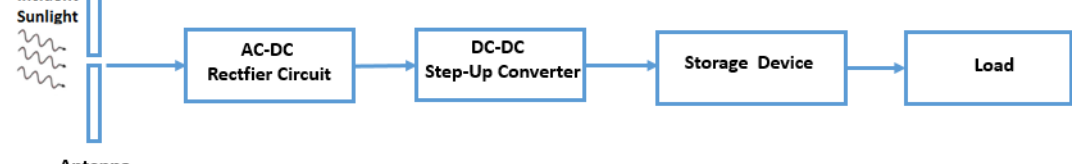
Figure 9. Block diagram of an energy harvesting